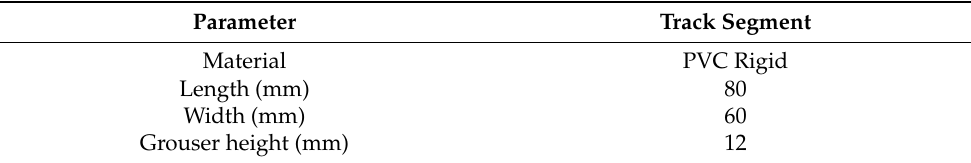
Table 3. Parameters of track segment structural dimension.